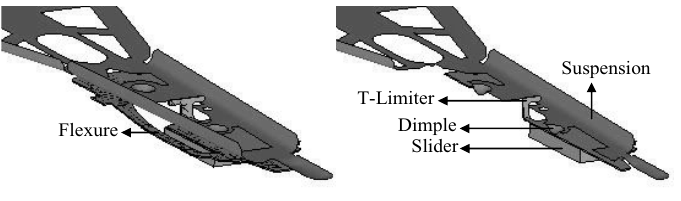
Fig. 1. Head-gimbal assembly device.